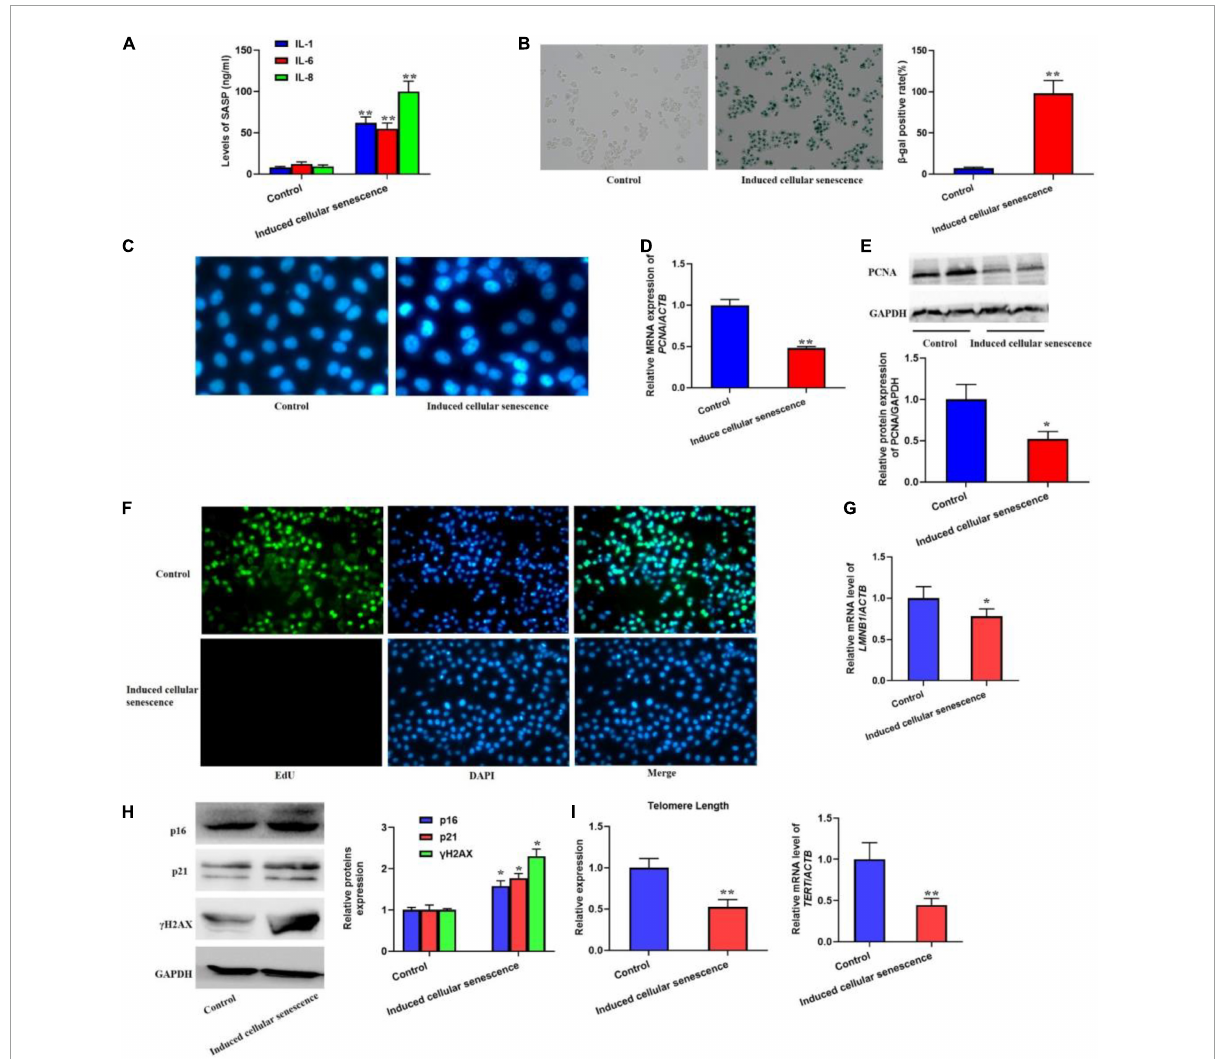
FIGURE2 The supernatant from replicative senescent cells induced cellular senescence. The cells were cultured by the supernatant from senescent cells for 6 weeks. (A) The secretion of IL-1, 6, and 8 were significantly increased in the supernatant. (B) The SA- β -gal activity was elevated. (C) The SAHF formation was increased. The decreased cell proliferation with downregulated expression of PCNA and EdU staining. (D) The relative mRNA expression of PCNA. (E) The protein levels of PCNA. (F) EdU staining. (G) The mRNA level of LMNB1 . (H) The protein expression of p16, p21, and γ H2AX. (I) The change of telomere length. All the data in this article were from three independent experiments ( N = 3). *Compared with control, p < 0.05; **compared with control, p < 0.01. The control of induced senescent cells is the L02 hepatocytes cultured by RMPI 1640 medium with 10% FBS and 1% penicillin-streptomycin for 7